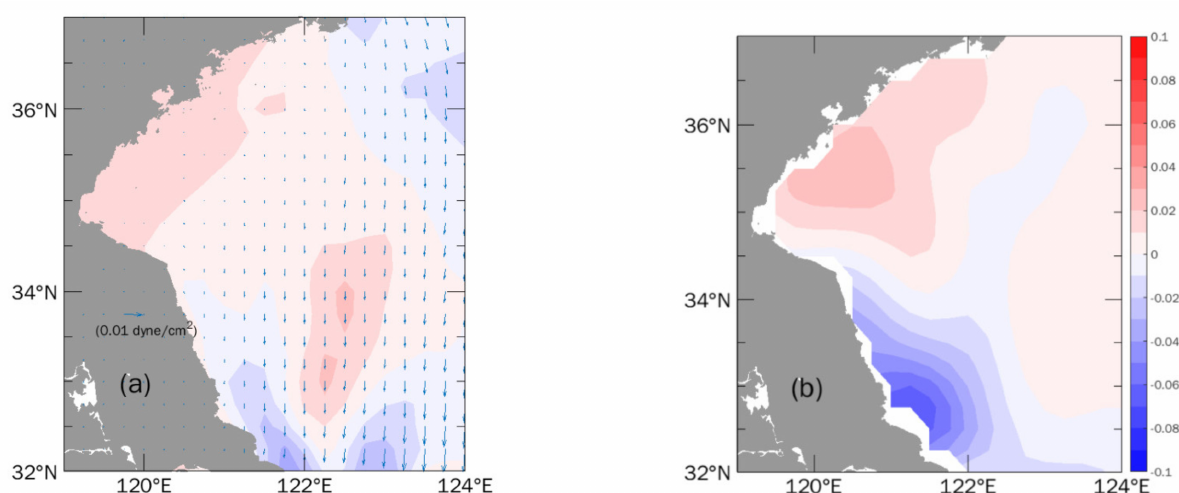
Figure 14. ( a ) Changes of the summer monsoon, with color indicating its curl, and ( b ) changes of summer sea level anomaly. Changes are 2011–2020 averages minus 2001–2010 averages. Red and blue shades represent positive and negative values,